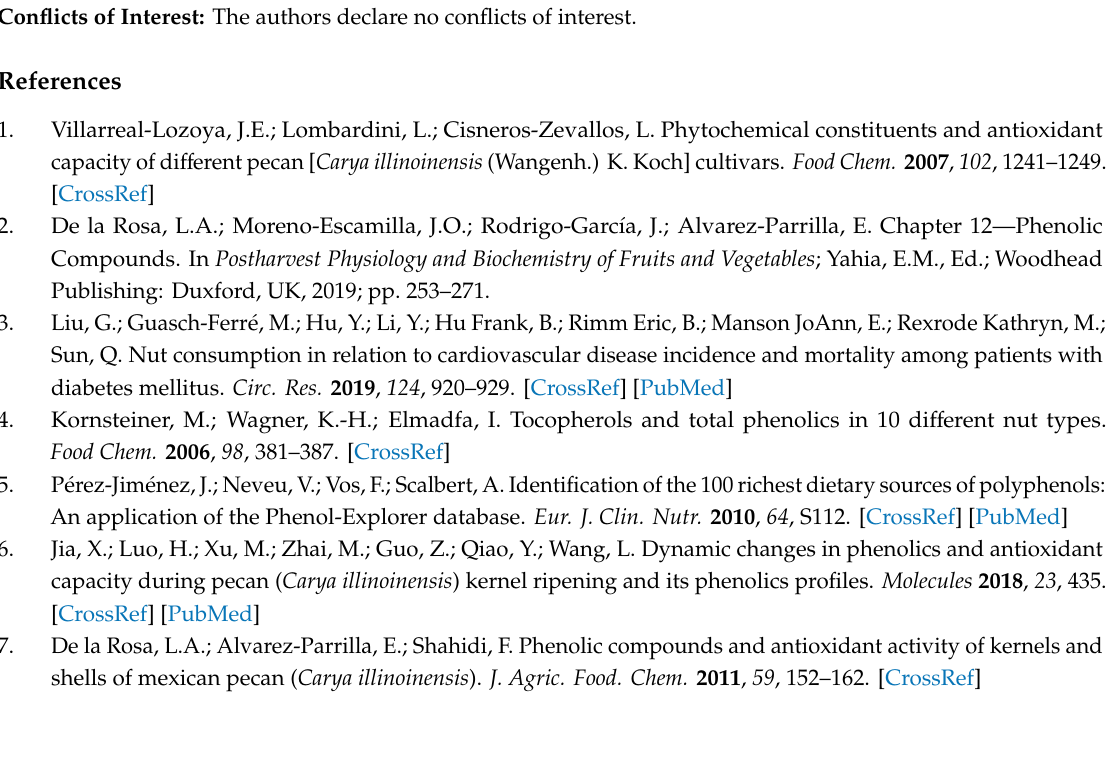
Table S1. Specific primers used in this study, Figure S1. The target PCR products of three full-length cDNA of CiCHSs , Figure S2. Full-length cDNA sequences of 3 CiCHSs